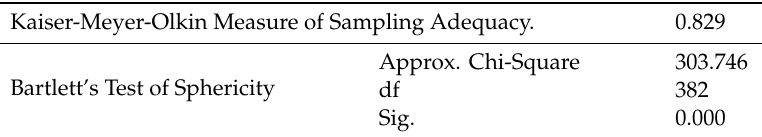
Table 7. Sampling adequacy test.